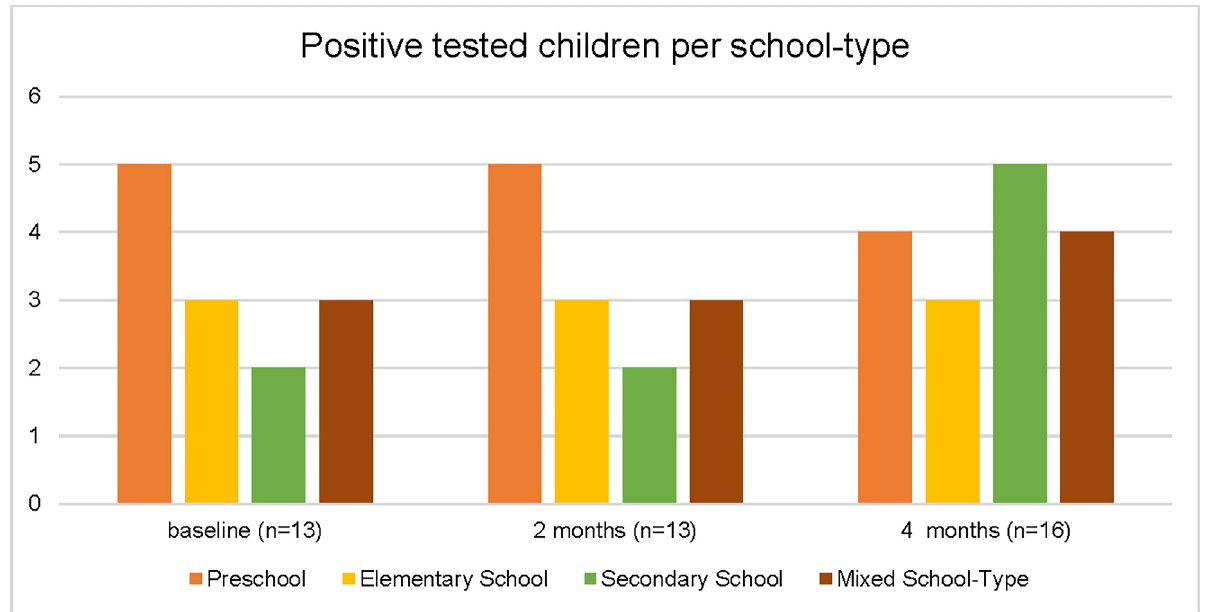
Fig 3. Children who tested positive per school-type (absolute numbers).